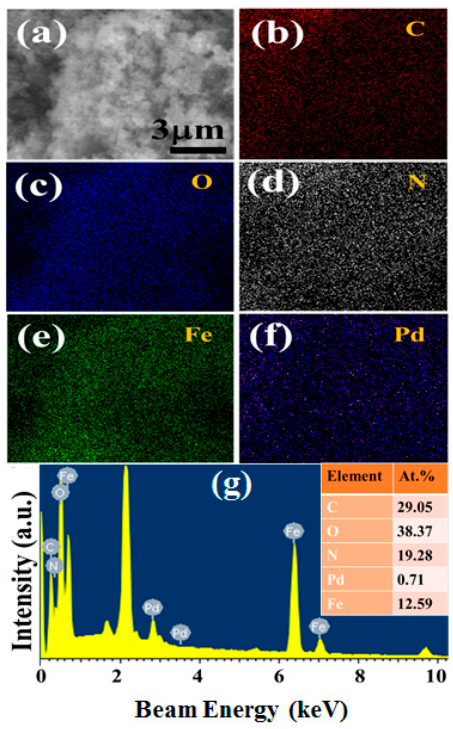
Figure 2. ( a ) SEM image of a Fe 3 O 4 /Pd/mpg-C 3 N 4 nanocomposite sample. ( b – f ) EDX element maps of the sample. The maps are displayed in the order of C, O, N, Fe, and Pd. ( g ) EDX spectrum of the sample.